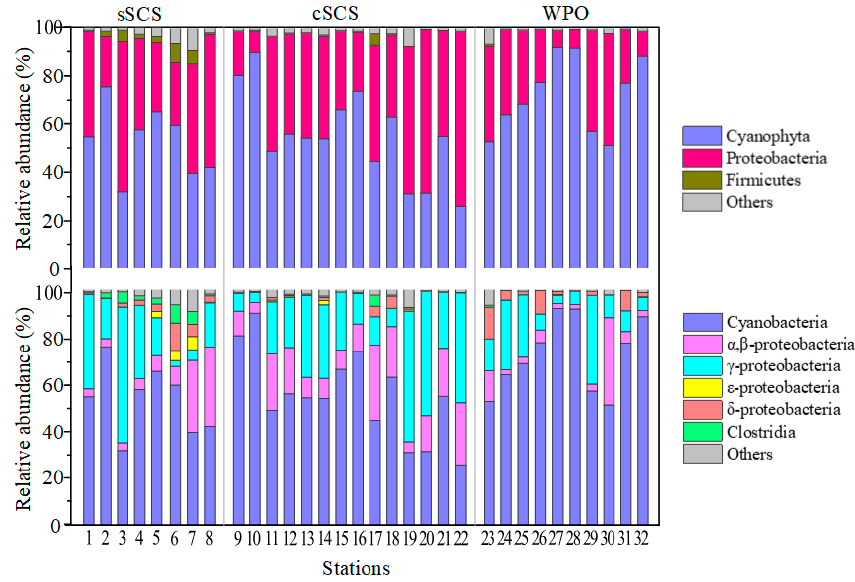
Figure A3. The relative abundances (%) of diazotroph groups at sampling stations.